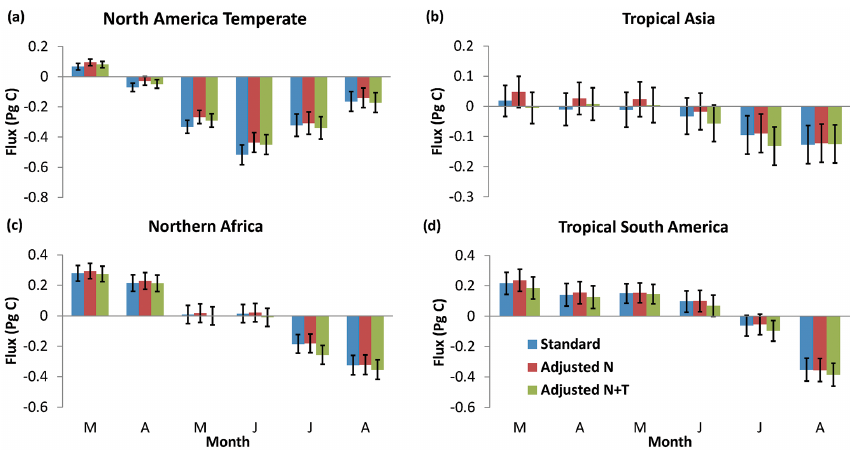
Figure 10. Monthly mean CO 2 flux estimates and their uncertainties for (a) temperate North America, (b) tropical Asia, (c) northern Africa, and (d) tropical South America. As in Fig. 9, shown are the results from using the standard inversion (denoted Standard), with an imposed sink in CO 2 in the Arctic UTLS (denoted Adjusted N), and with the addition of uniform source in the upper troposphere in the northern tropics (denoted Adjusted N +